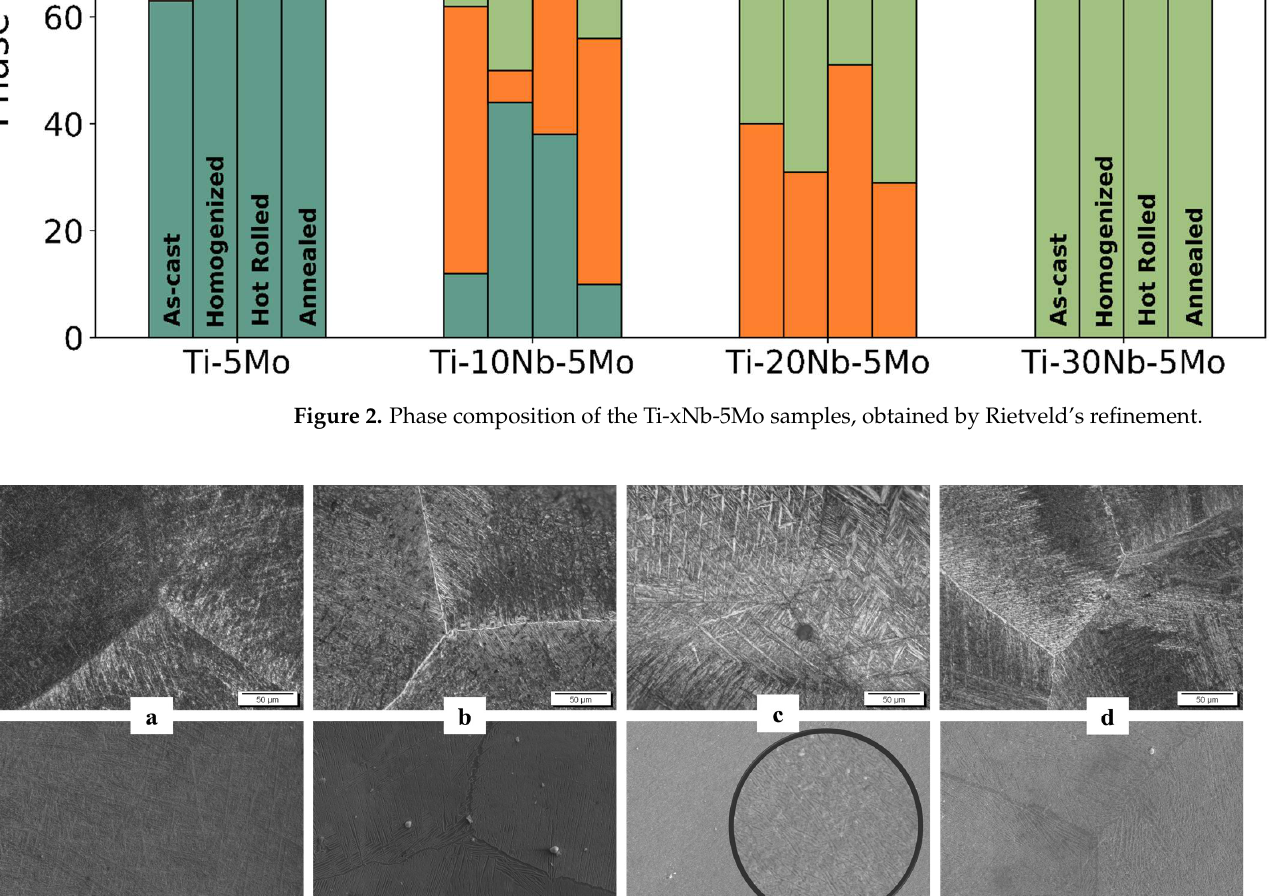
Figure 4. Optical micrographs (above) and SEM micrographs (below) in as-cast ( a ), homogenized ( b ), hot rolled ( c ), and annealed ( d ) conditions, for Ti-10Nb-5Mo samples.